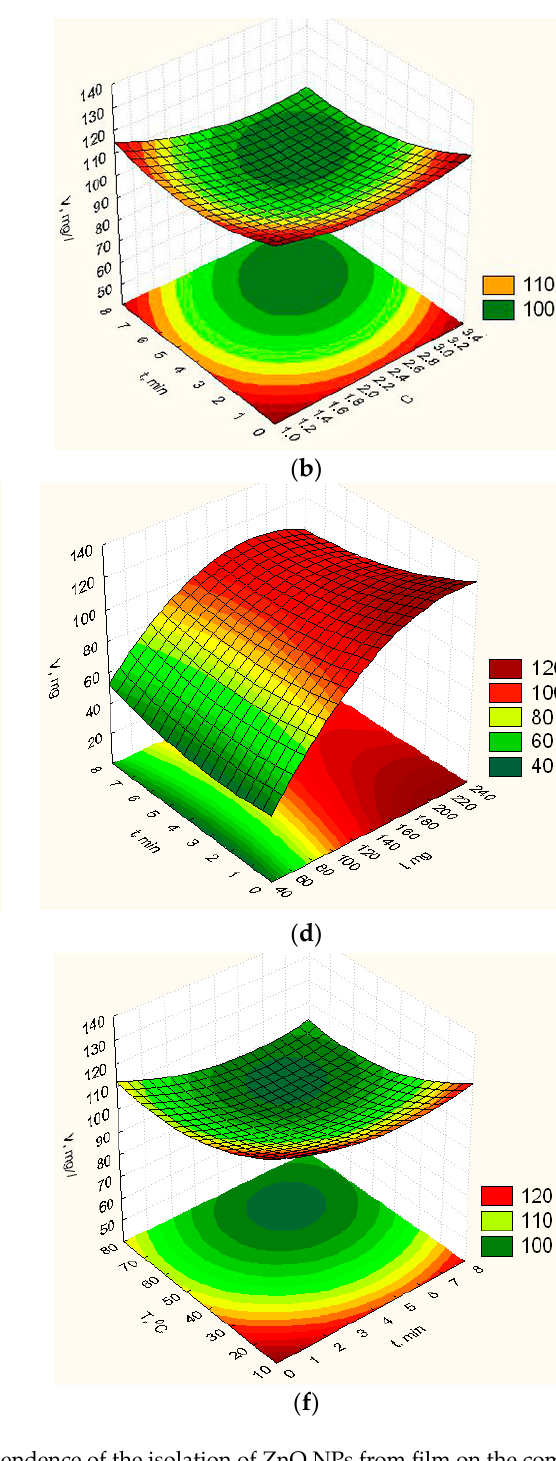
Figure 4. Response surfaces of dependence of the isolation of ZnO NPs from film on the composi- tion and technological parameters of its manufacture: ( a )— С , І , t = 4 min, T = 46 °C; ( b )— С , І = 140 and technological parameters of its manufacture: ( a )— C , I , t = 4 min, T = 46 ◦ C; ( b )— C , I = 140 mg/L, mg/L, t , T = 46 °C; ( c )— С , І = 140 mg/L, t = 4 min, T ; ( d )— С = 2.2, І , t , T = 46 ° C; ( e )— С = 2.2, І , t = 4 t , T = 46 ◦ C; ( c )— C , I = 140 mg/L, t = 4 min, T ; ( d )— C = 2.2, I , t , T = 46 ◦ C; ( e )— C = 2.2, I , t = 4 min, T ; min, T ; ( f )— С = 2.2, І = 140 mg/L, t , T. ( f )— C = 2.2, I = 140 mg/L, t , T